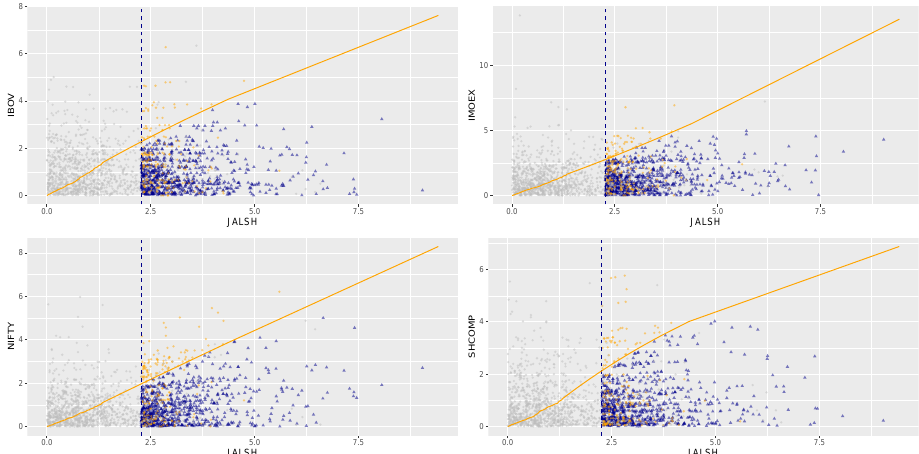
Figure 11. Prediction plot conditioning on JALSH being above its 90th